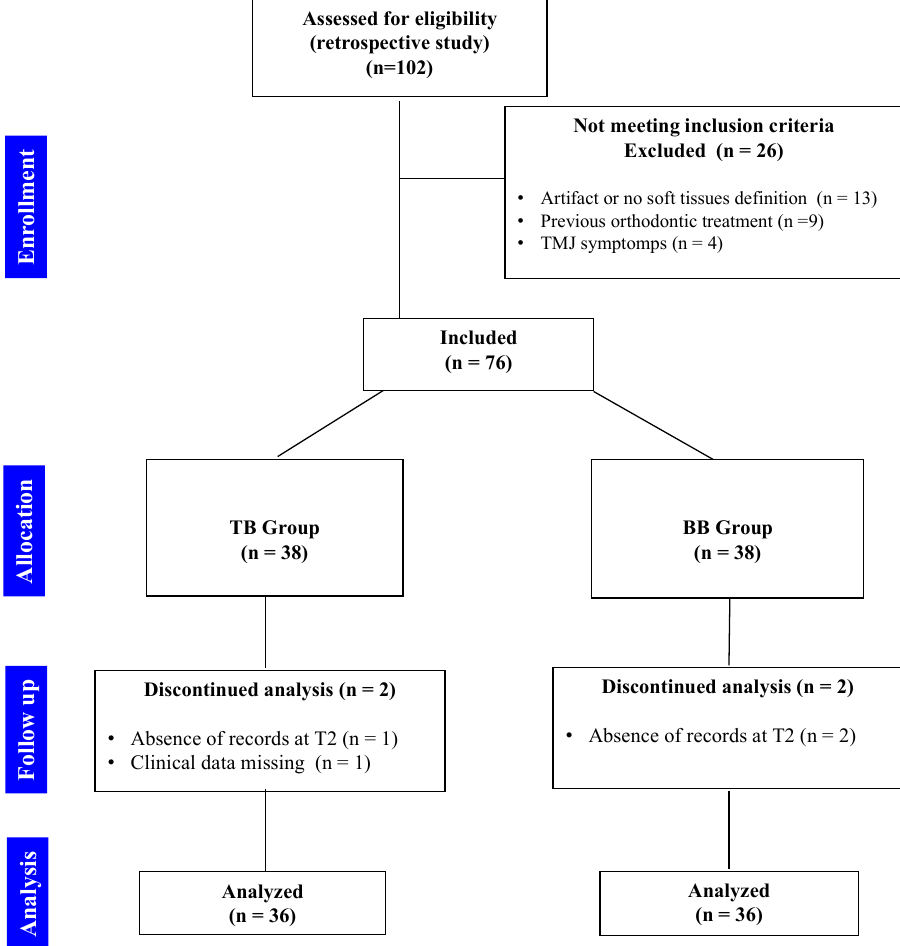
Figure 1. Flowchart showing data recruitment of the present retrospective study.